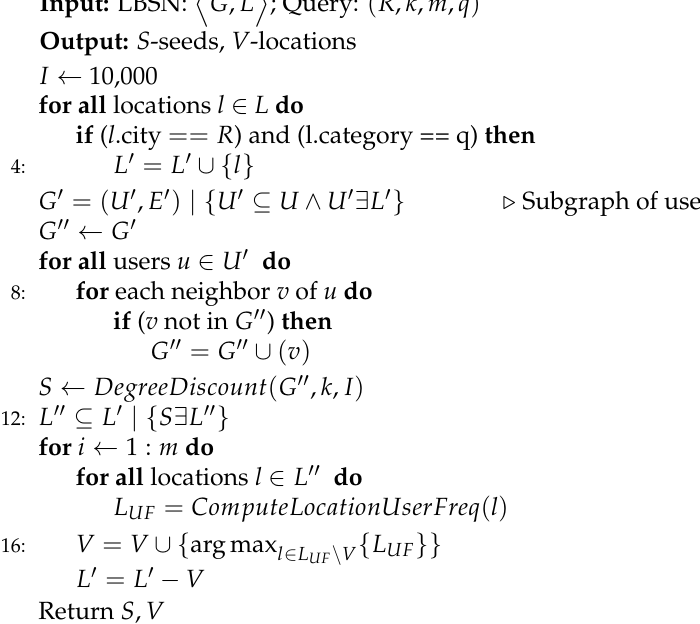
Algorithm 4 t-RF Selection of influential users and